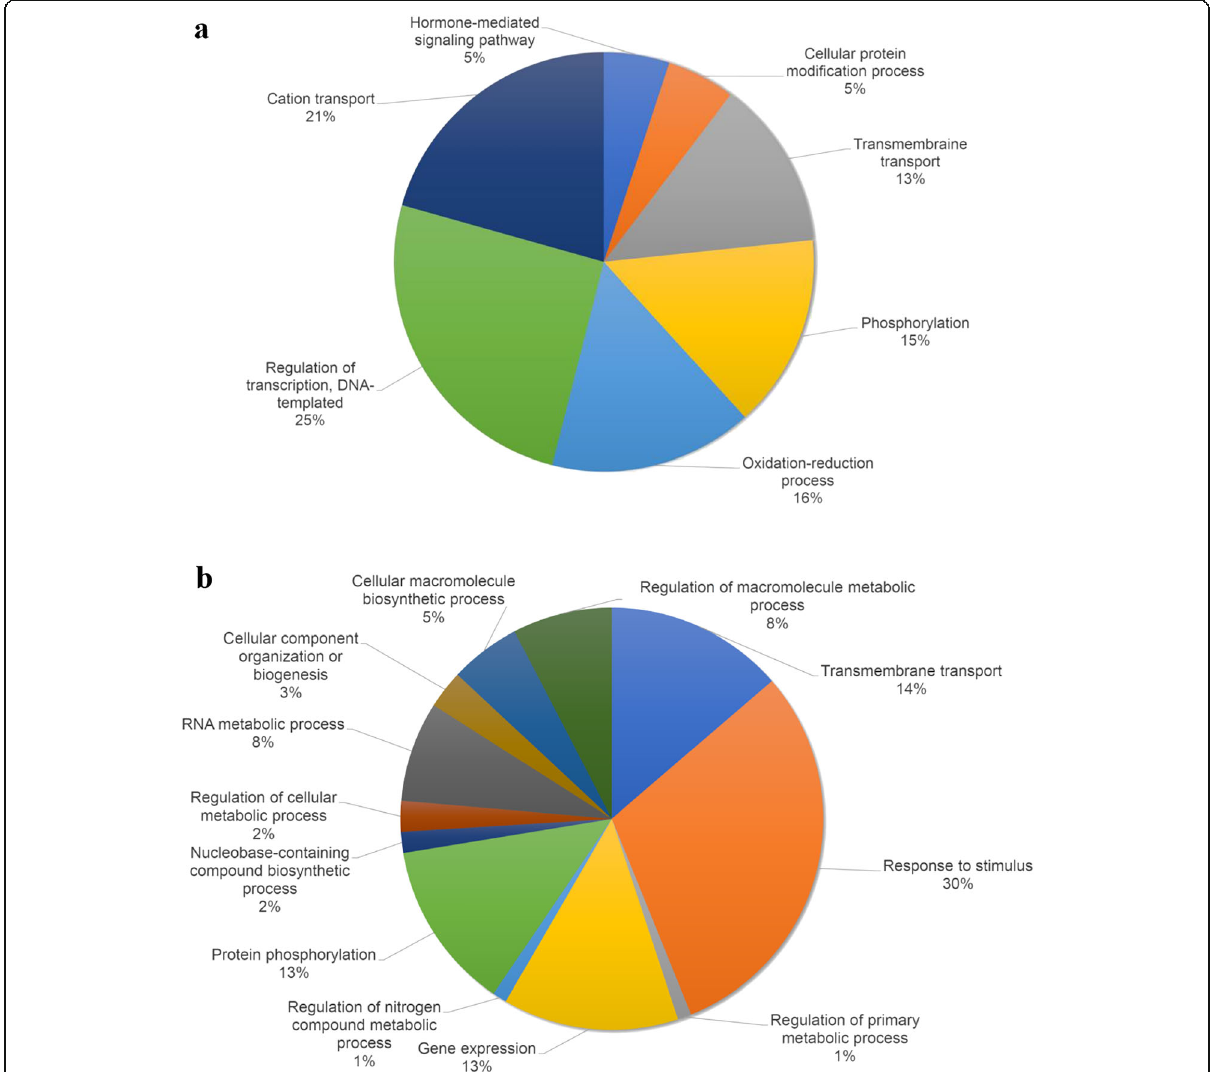
Fig. 5 Distribution of the predicted target genes in gene ontology terms of the biological process category. a Predicted target genes of the identified known miRNAs. b Predicted target genes of the putative novel miRNAs. “ Regulation of transcription ” and “ Response to stimulus ” comprised the most abundant target genes of the identified known miRNAs and putative novel miRNAs,